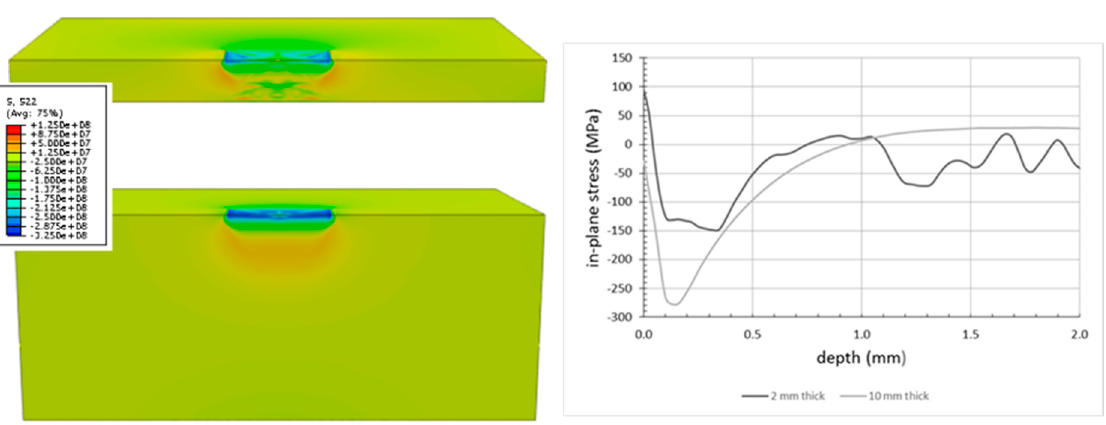
Figure 5. Effect of plate thickness on predicted in-plane residual stress (single square LP shot, 5 × 5 mm 2 , on a 2-mm-thick Al2024-T351 plate).